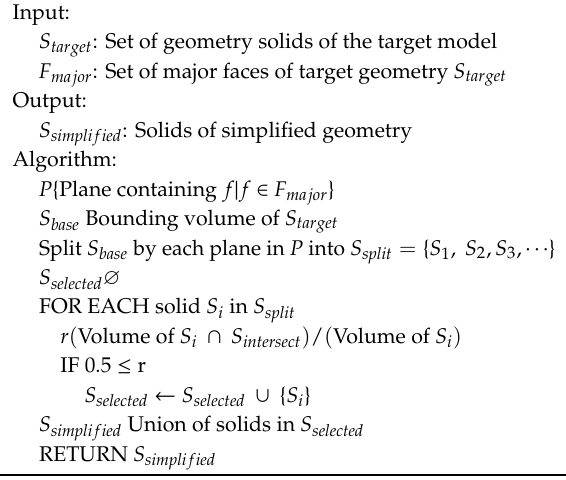
Figure 3. Classification of minor face on 3D building model; 𝑐⃗ (cid:3036) is the center, 𝑛(cid:4652)⃗ (cid:3036) is the unit normal of face 𝑓 (cid:3036) , 𝑝⃗ is the foot of perpendicular from 𝑐 (cid:2870) to 𝑓 (cid:2869) . Algorithm 1 Pseudocode for face classification